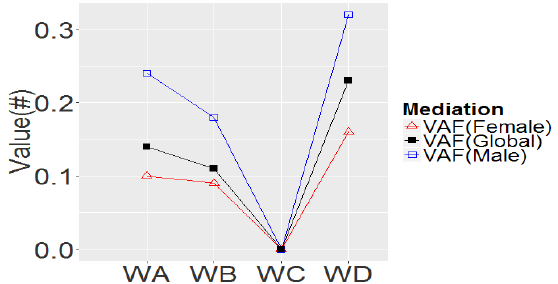
Fig. 6. Usability mediation effect of aesthetics on credibility